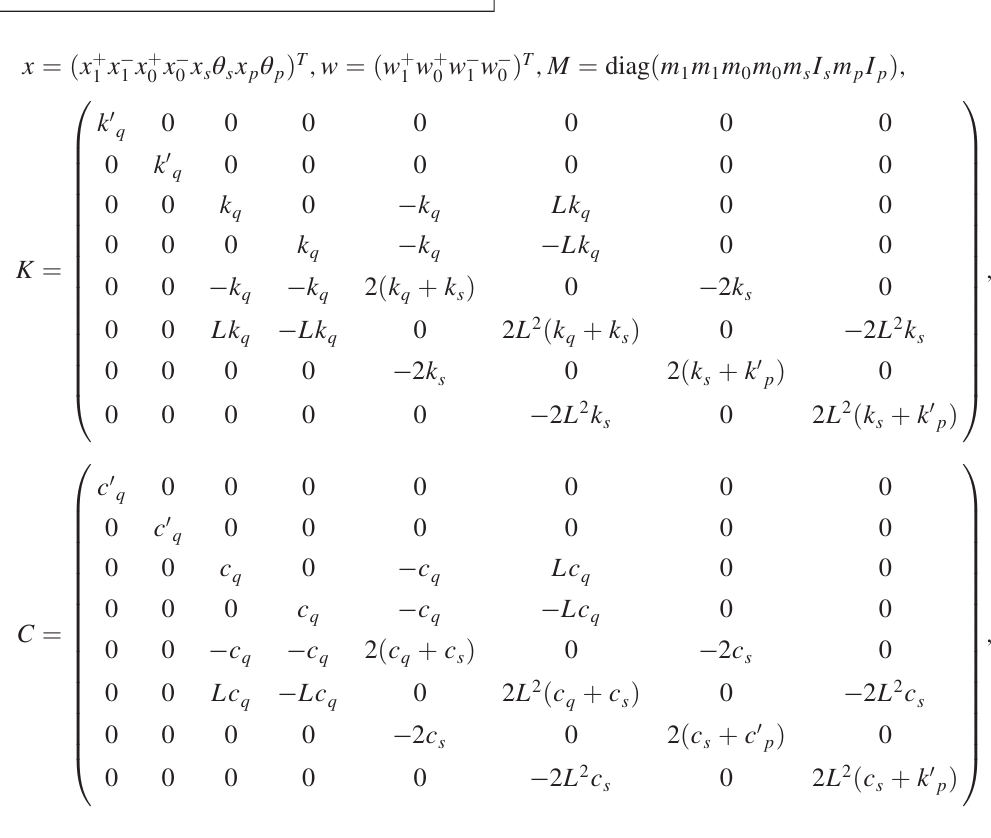
Fig. 2. The last four quadrupoles (QD0 and QF1 on each side) are represented by masses m 0 and m 1 . The detector , is supported on a rigid structure, represented by m s platform, represented by m . Both have a vertical and tilt p degree of freedom. The dominant mass of the detector is the iron for the flux return of the magnetic field. Although the iron is split in two doors and a central barrel, in working condition the mass of the doors is attracted by large forces toward the barrel, making a single lumped mass a good approximation of the dynamic behavior of the detector. That is also true for the platform, which is a single solid slab of reinforced concrete. The system includes also a model of the ground, represented by k [16]. g The dynamics of the system reads